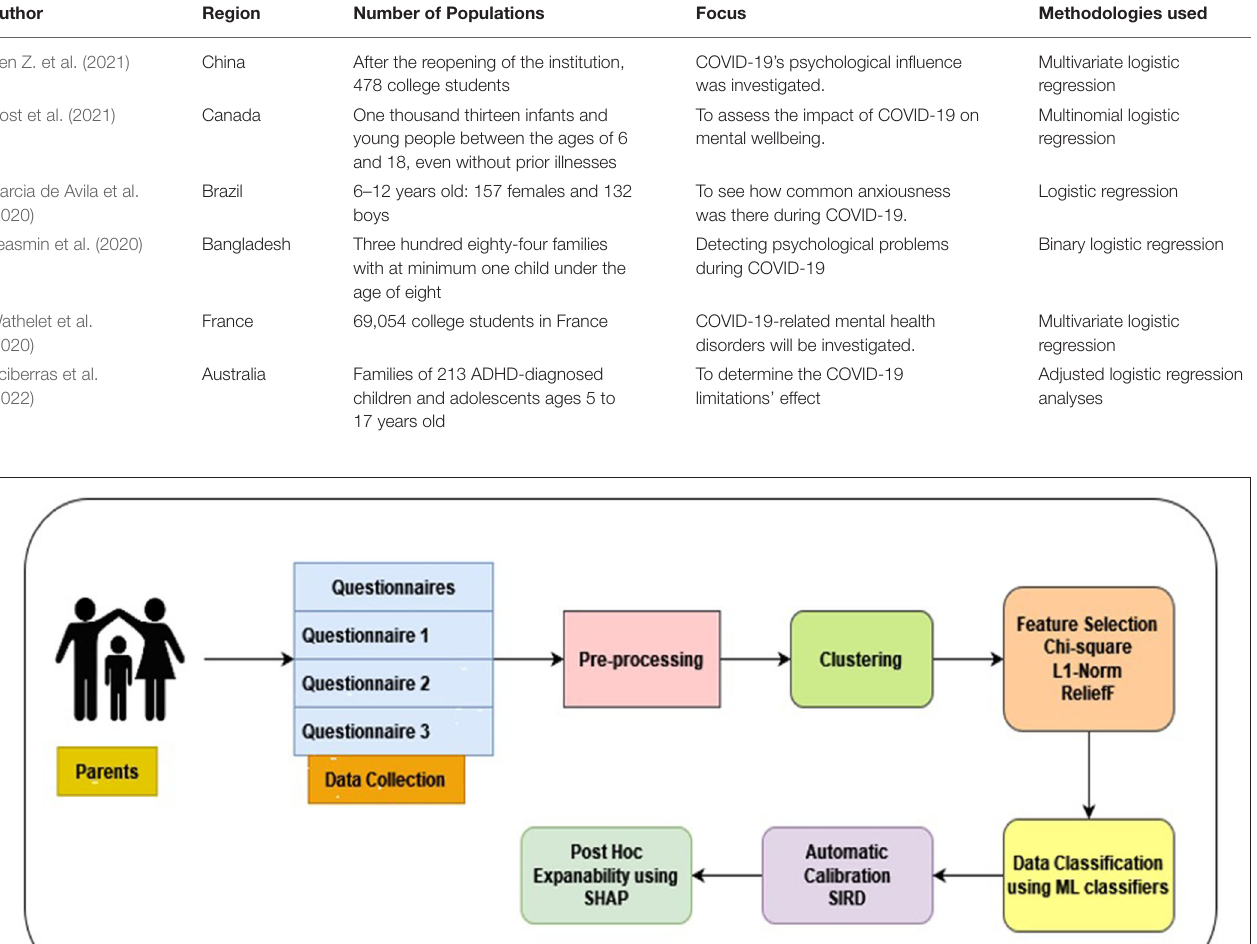
TABLE 1 | A summary of research on the first COVID-19 pandemic, which included teens and young people.